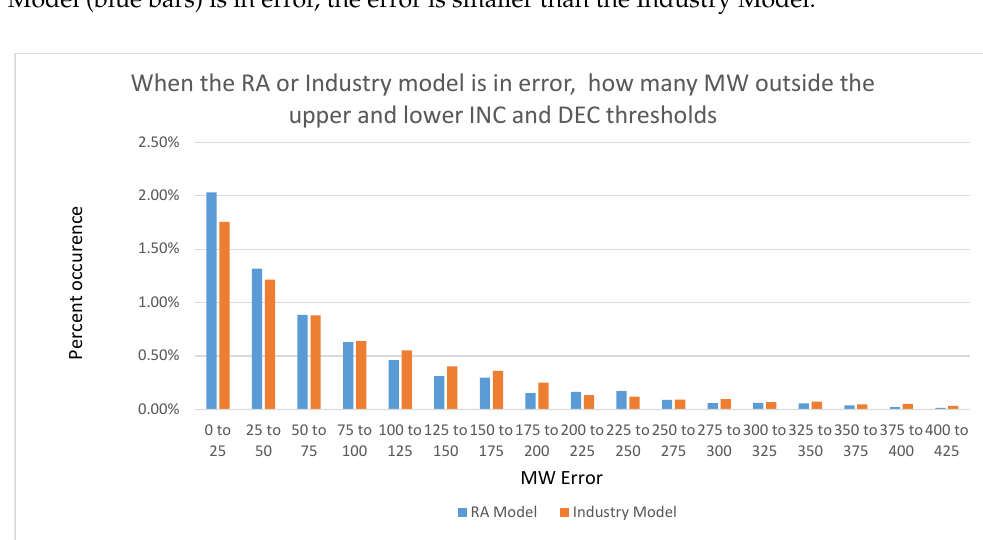
Table 14. RA Backup Model Point Estimate Summary Statistics.